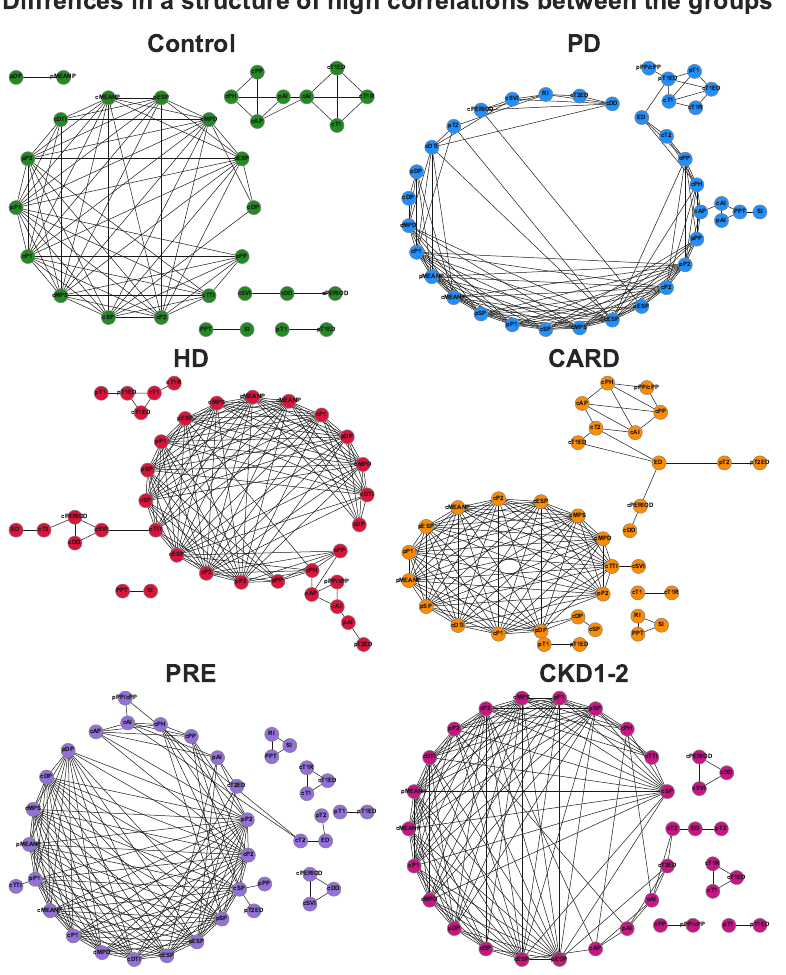
Figure 4. Correlation graphs representing only strong correlations between the parameters (Spearman ρ ≥ 0.7 and p <